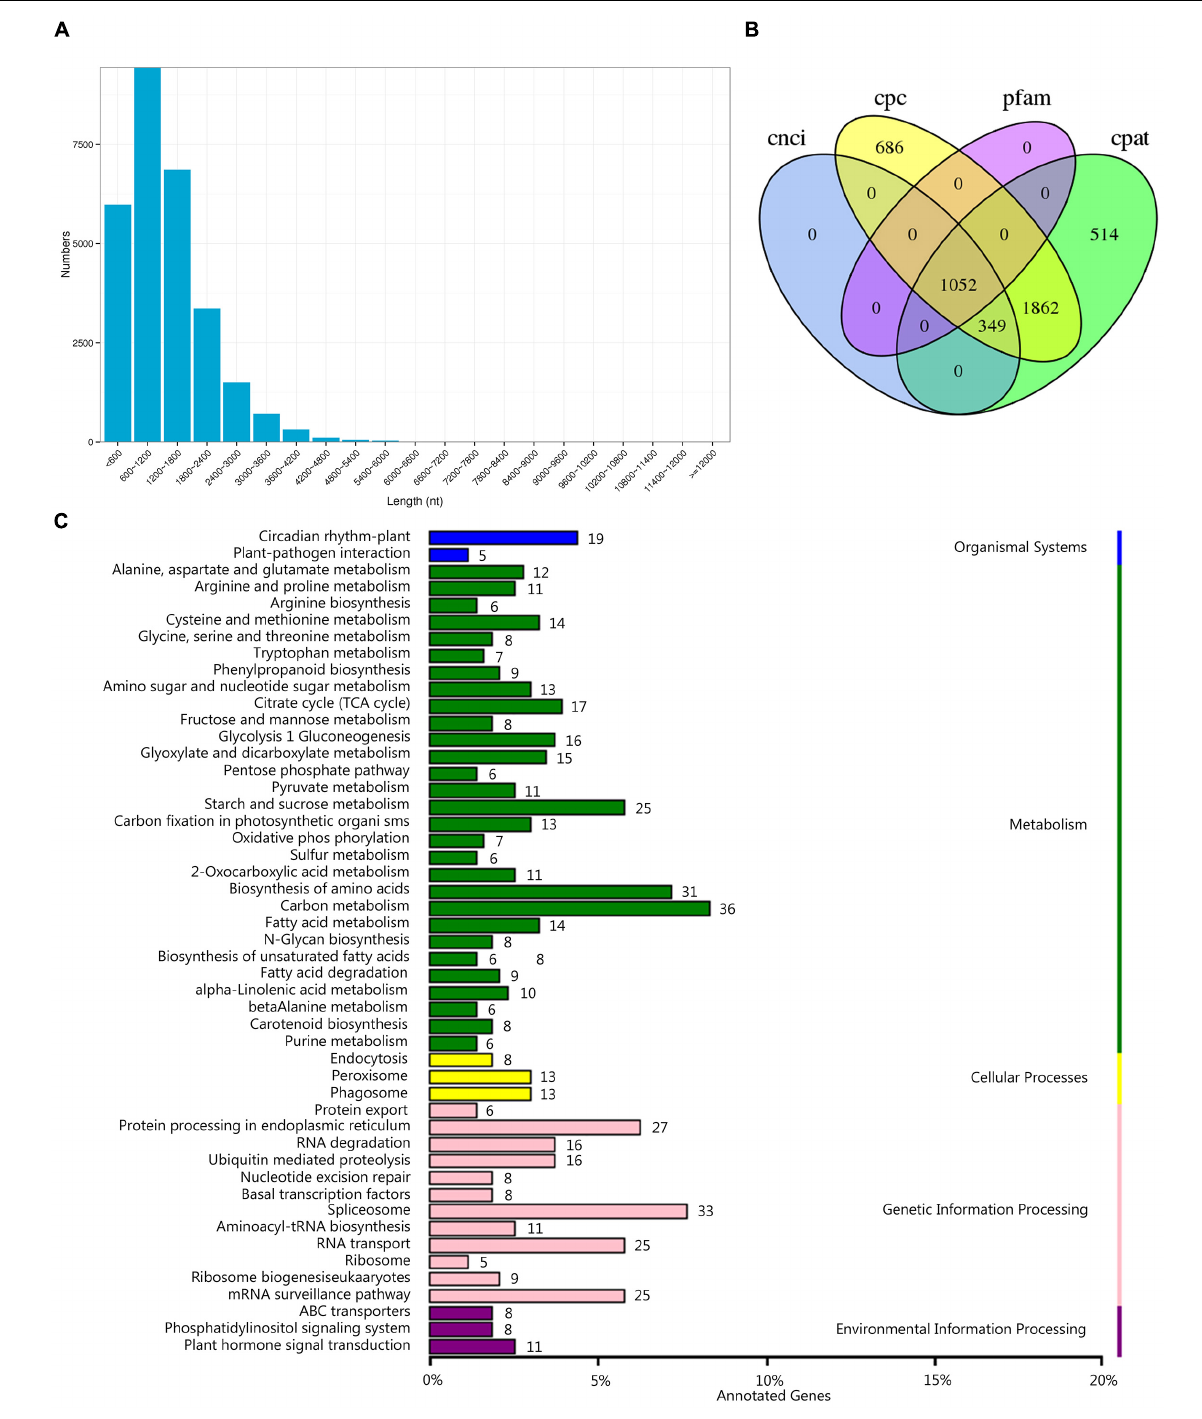
Frontiers in Plant Science |